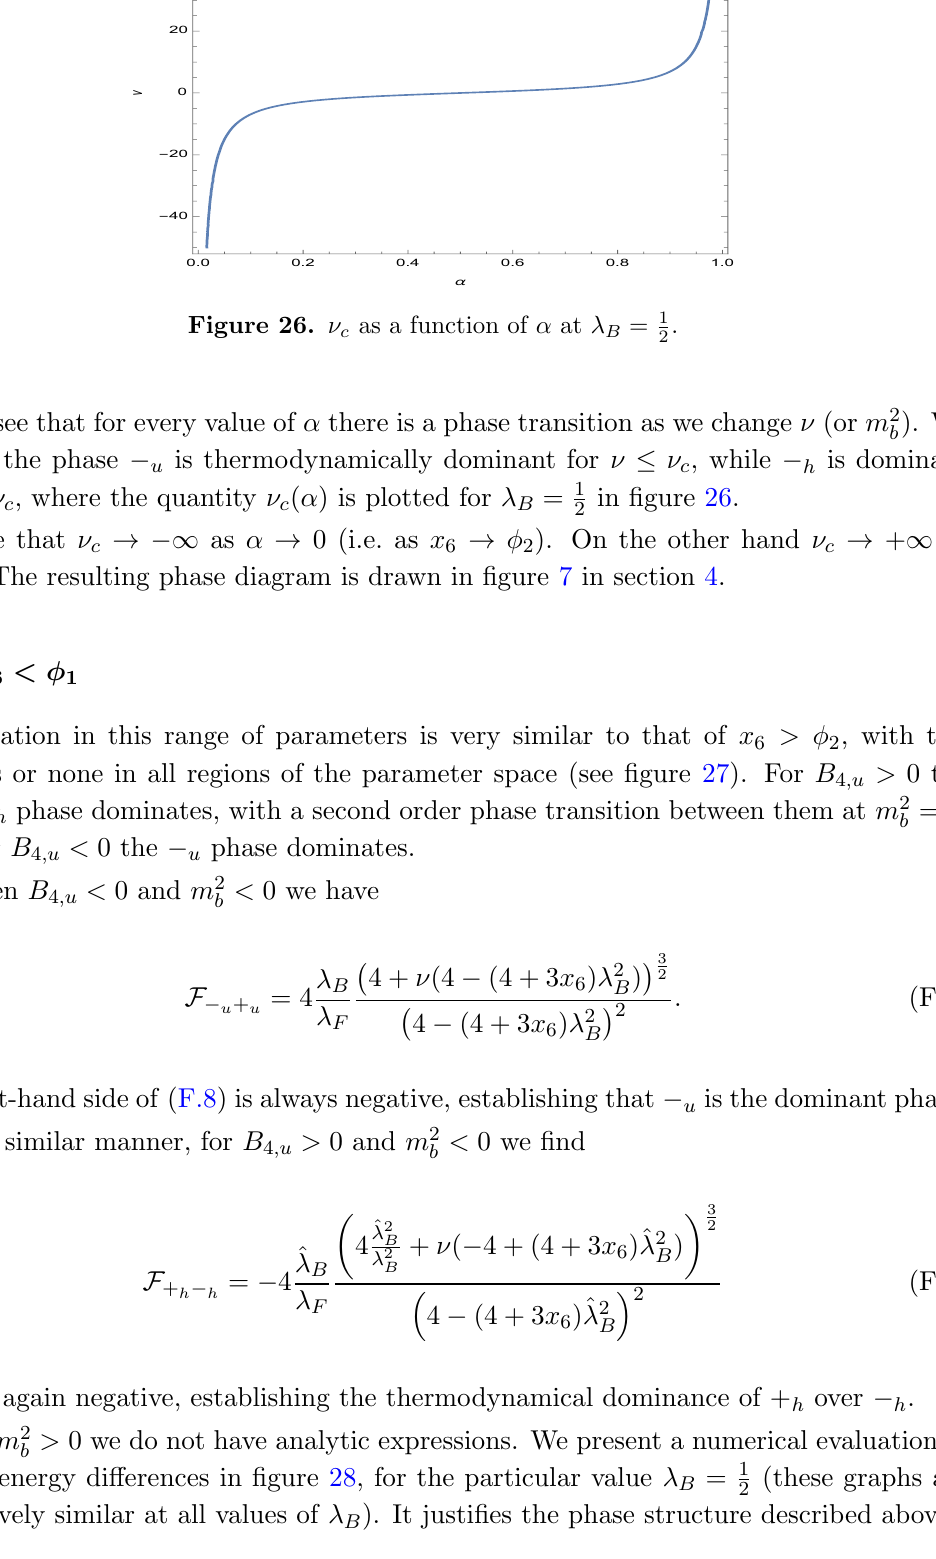
Figure 26. (cid:23) c as a function of (cid:11) at (cid:21) B = 1